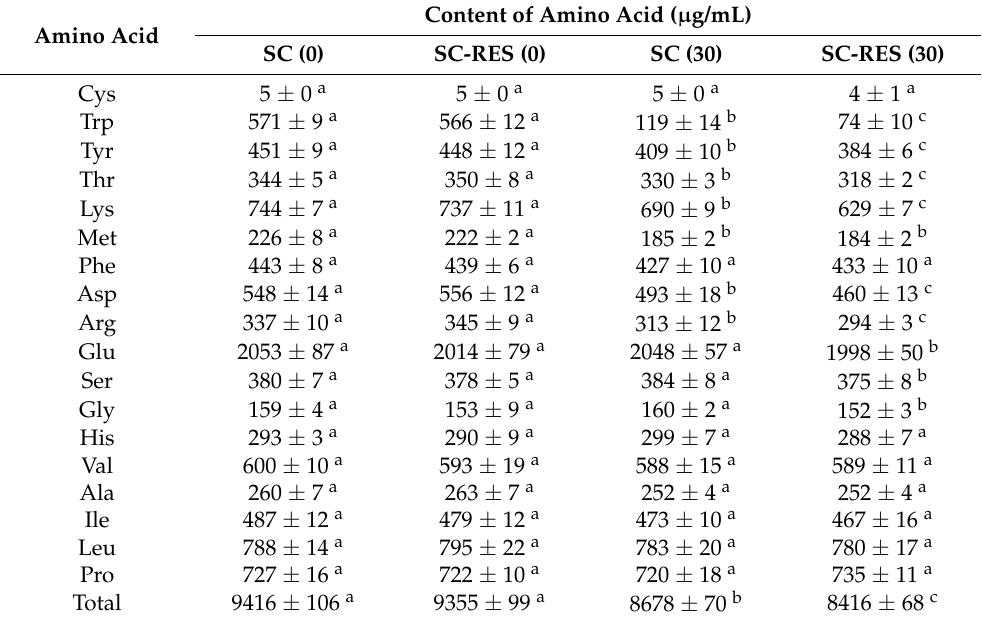
Table 2. Amino acid composition of sodium caseinate (SC) in the absence and presence of resveratrol (RES) before and after storage for 30